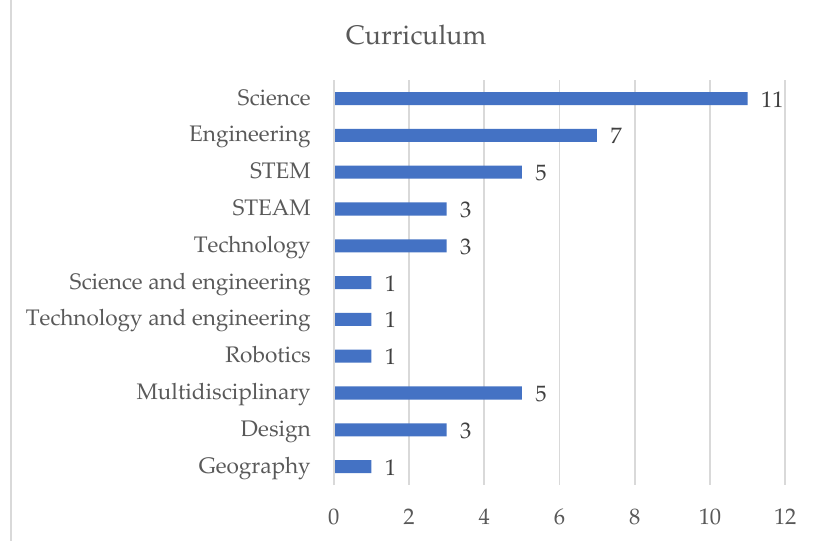
Figure 5. Curriculum of the reviewed papers.